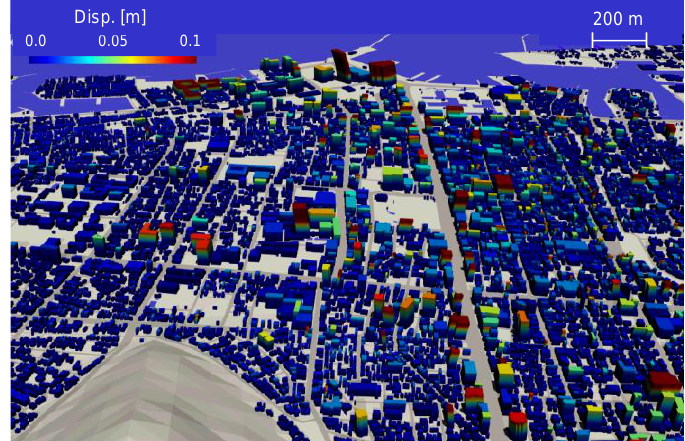
Figure 5. Example of visualizing the seismic responses of buildings.